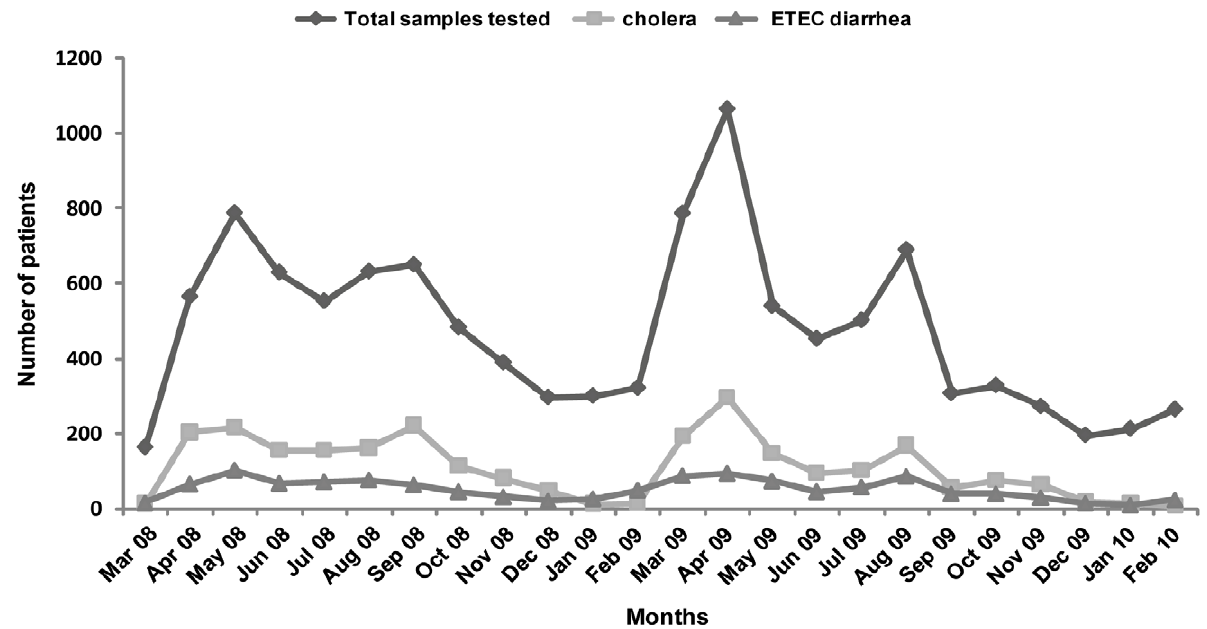
Figure 1. Seasonality of cholera and ETEC diarrheal patients.